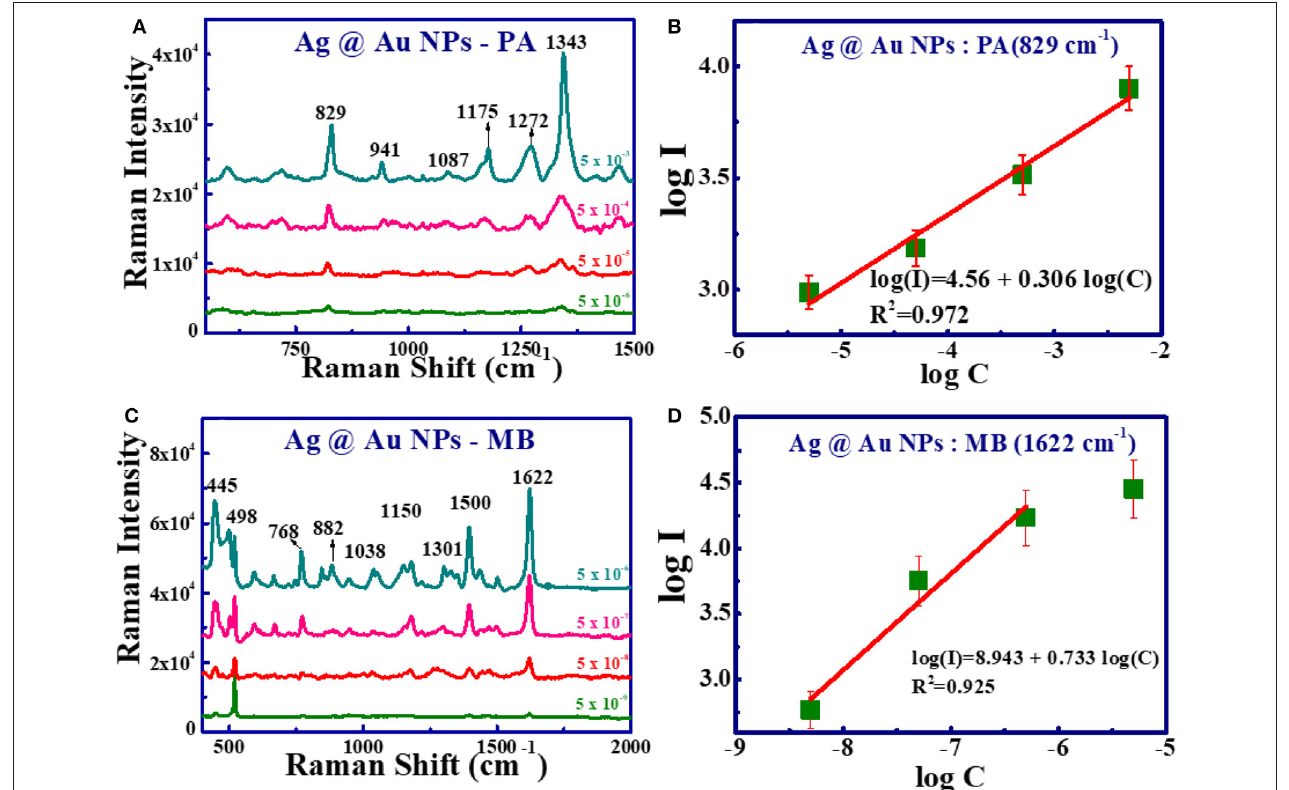
FIGURE 9 | Concentration-dependent SERS spectra of PA and MB recorded using Ag@Au NPs. (A) PA with concentration from 5mM to 5 µ M. (B) SERS intensity at 829 cm − 1 vs. PA concentration. (C) MB spectra from 5 µ M to 5nM. (D) SERS intensity at 1,622 cm − 1 vs. MB concentration (Solid green squares represent the experimental data and red line represents the theoretical